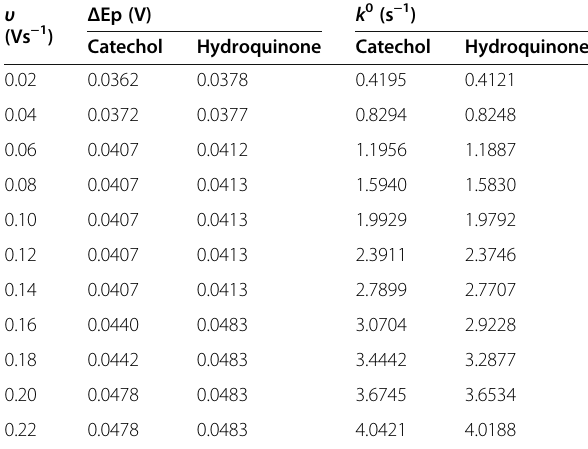
Table 1 k 0 values calculated for the electrooxidation of CC and HQ